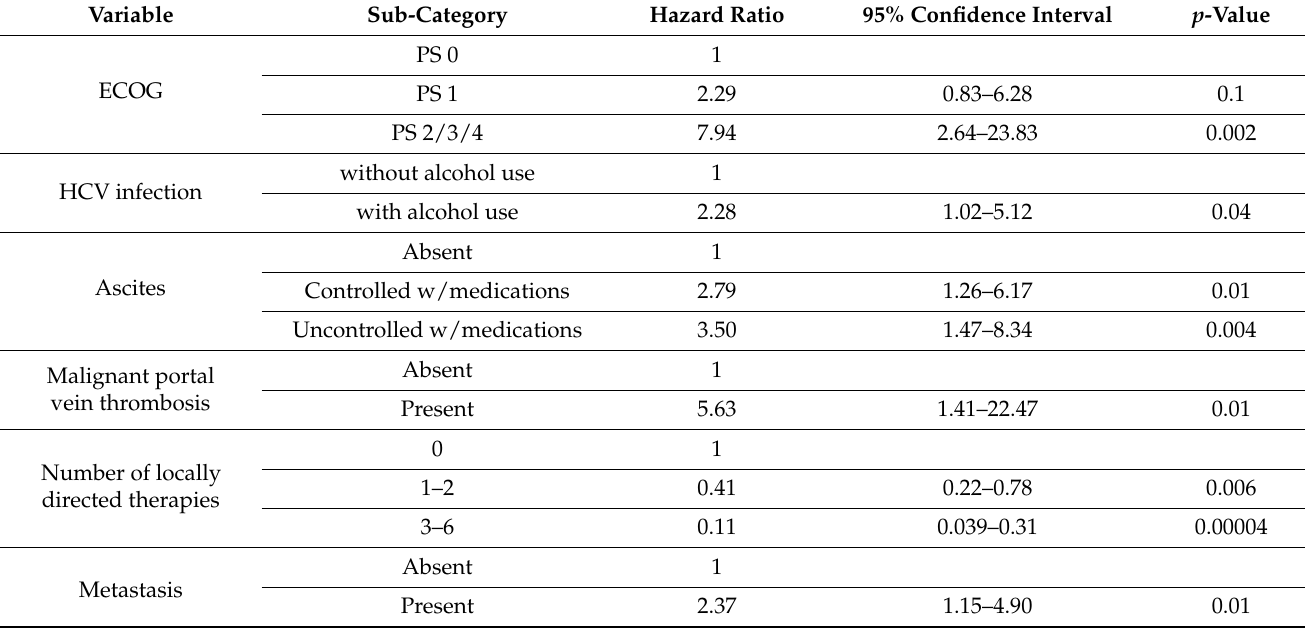
Table 3. Summary of findings from multivariate analysis for patients with HCC at